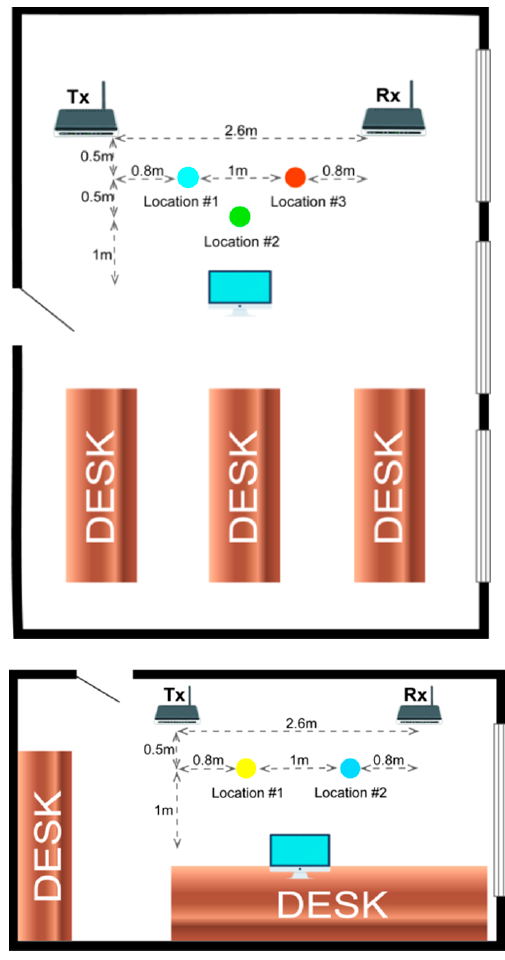
Figure 2. The layout of the two indoor environments, the upper one is Room1 and the lower is Room2.